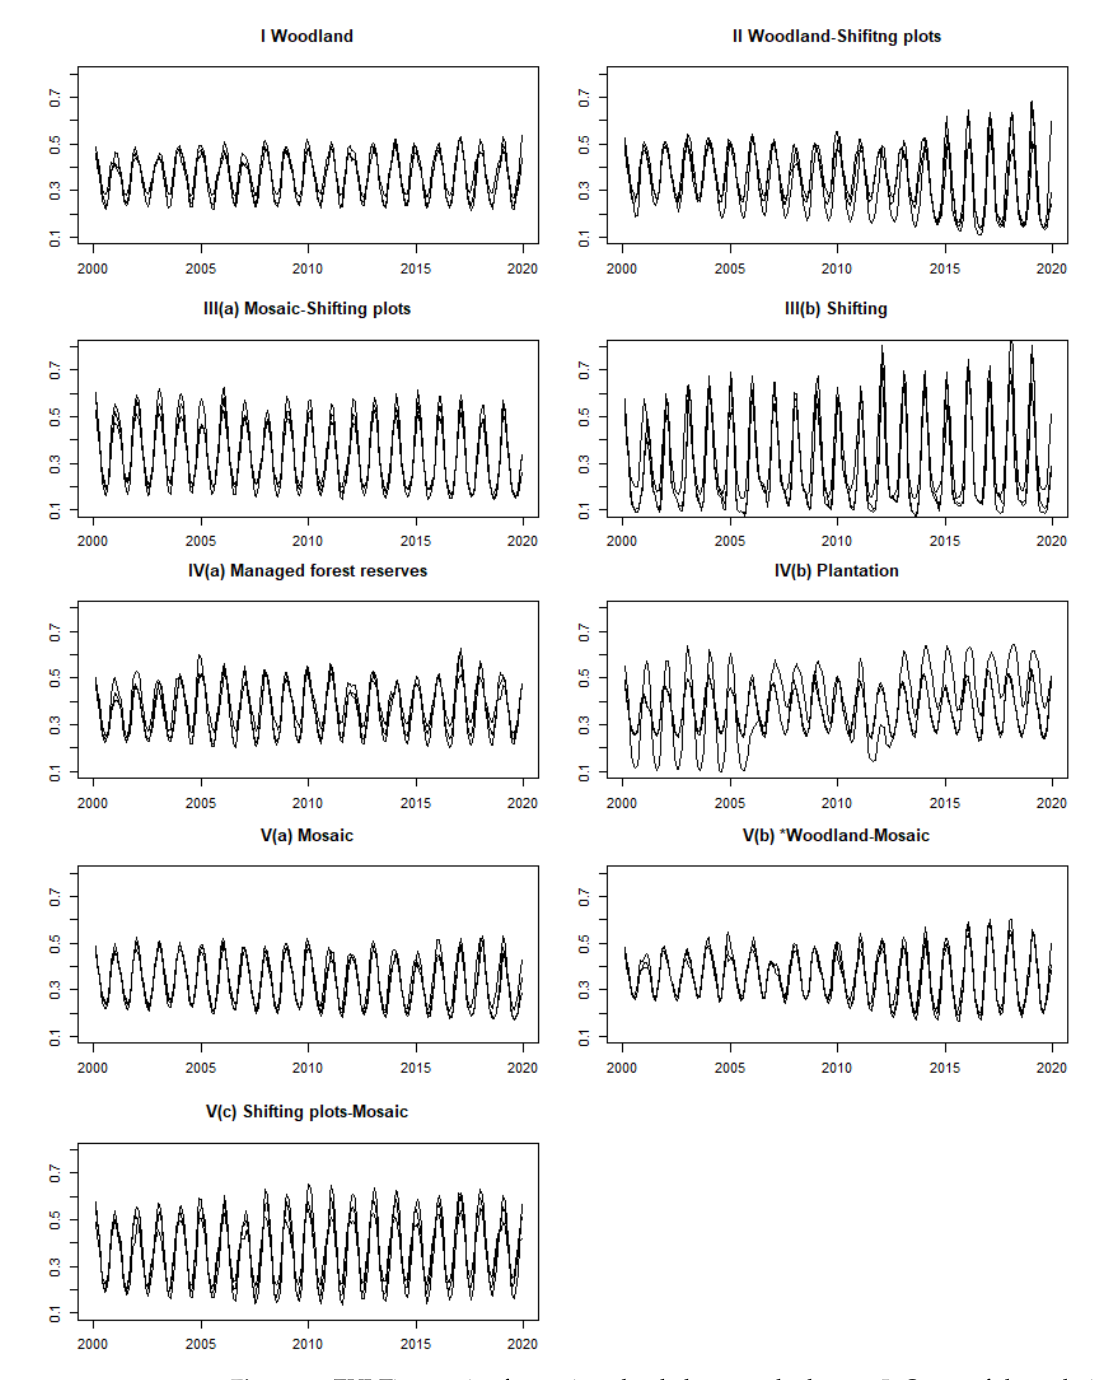
Figure 7. EVI Time series for various land change sub classes: I : Onset of degradation, II : New encroachment, III : Ongoing degradation, VI : Managed conservation, V : Natural regeneration. * Intermediate conversion to shifting plots. Each plot shows three time series.